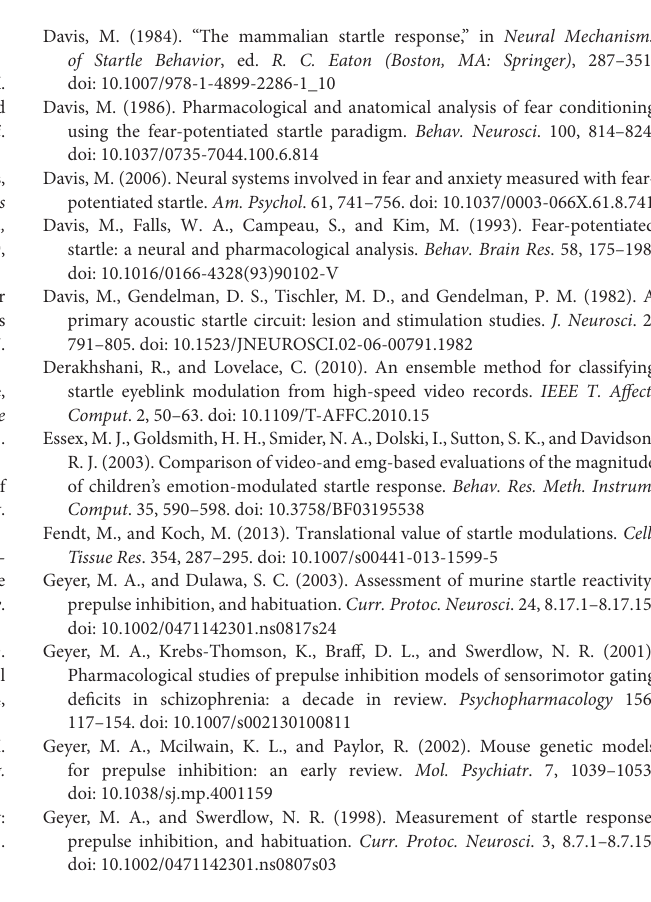
Supplementary Movie 2 | The startle response as captured by a high-speed imaging system. Supplementary Data 1 | Data sheet corresponding to Figure 1 (Input/output function) in the article. Supplementary Data 2 | Data sheet corresponding to Figure 4 (Prepulse inhibition) in the article. Supplementary Figure 1 | Input/output function with individual animal data. Supplementary Figure 2 | Startle amplitude by animal orientation. Supplementary Figure 3 | Prepulse inhibition (PPI) with individual animal